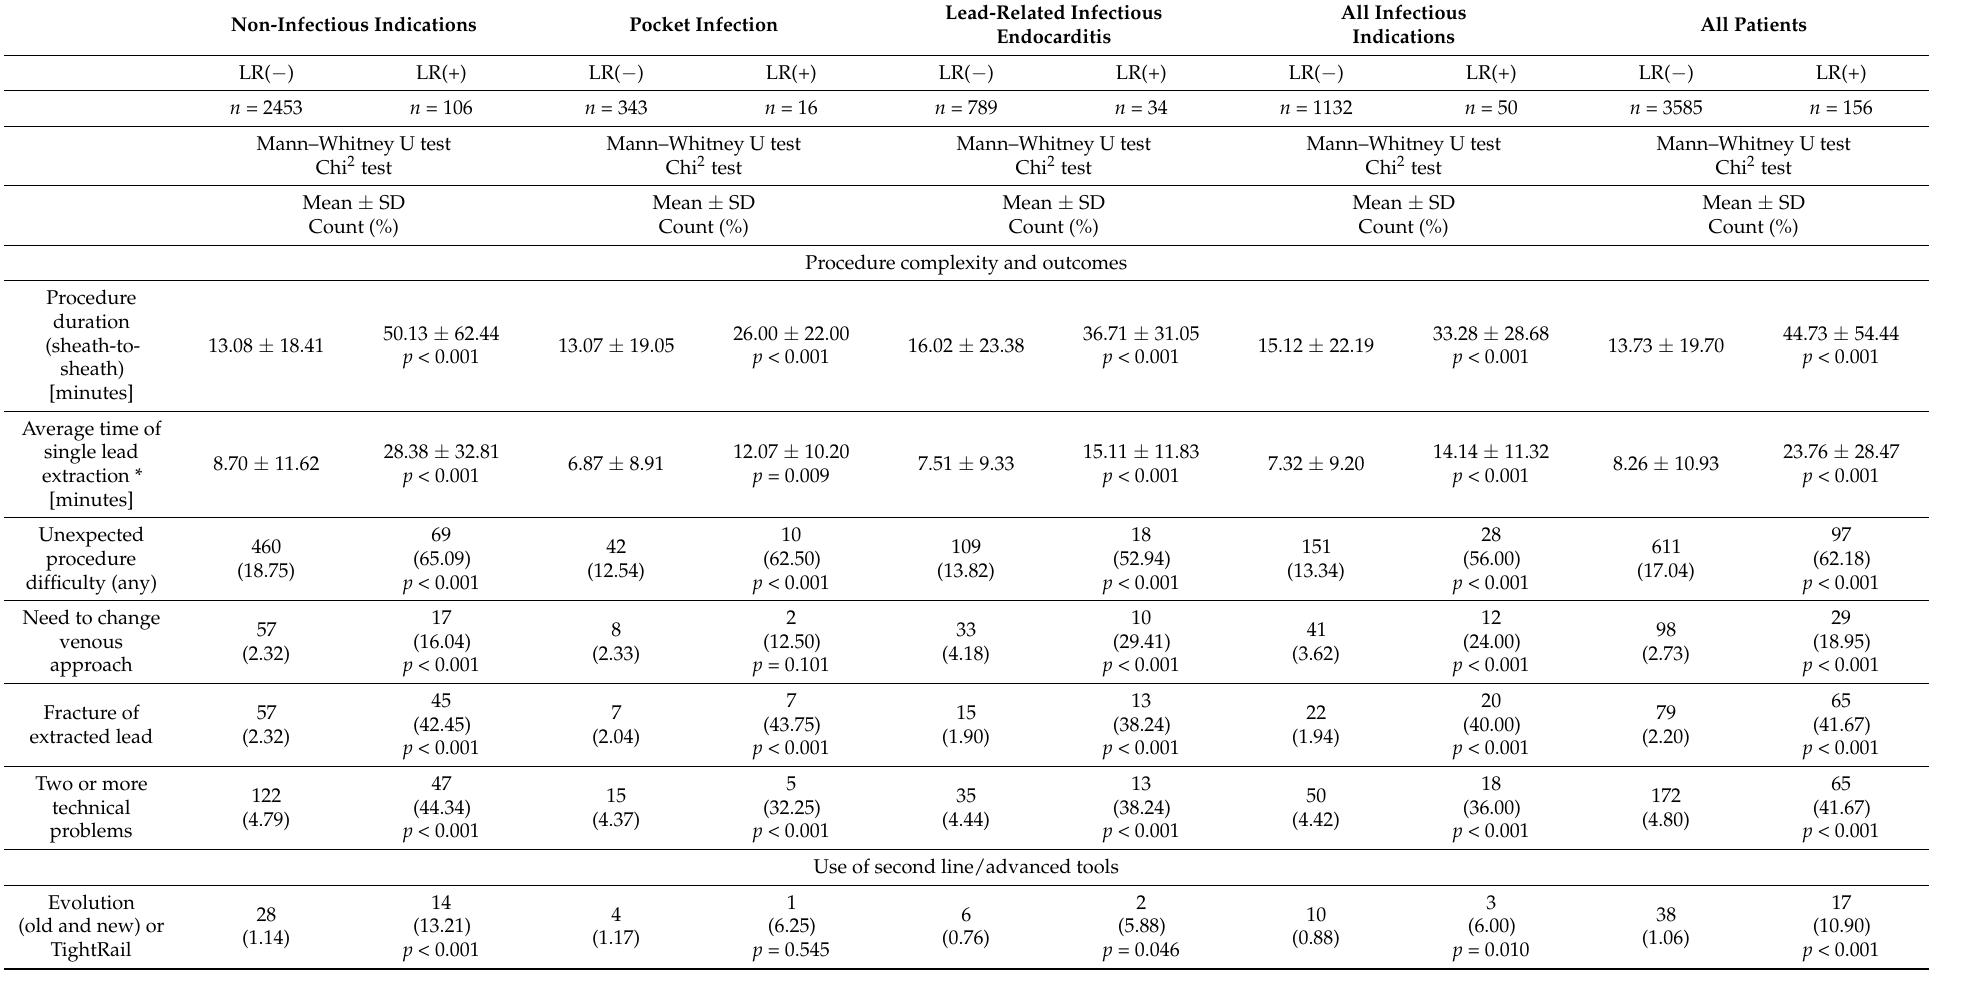
Table 3. TLE complexity, complications, effectiveness and short- and long-term